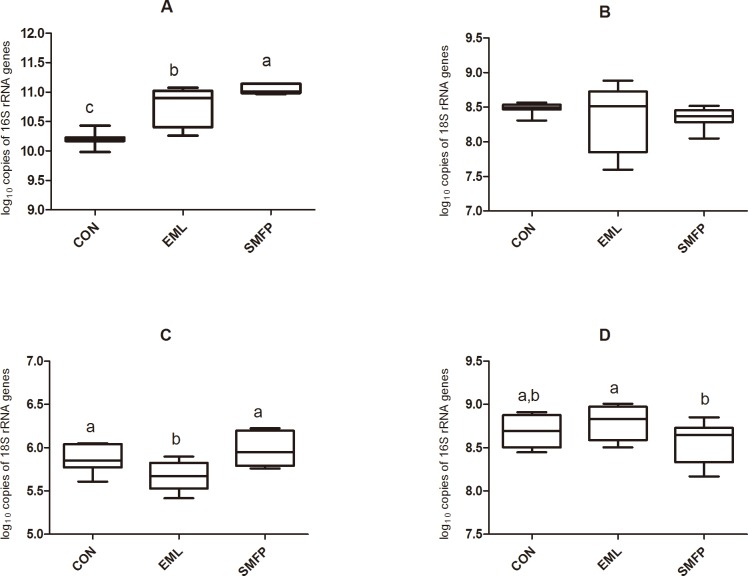
Abundance of microflora in the rumen of finishing steers when corn grain- and cotton seed meal-based concentrate was partially replaced with EML or SMFP.(A), abundance of total bacteria in the rumen; (B), abundance of fungi in the rumen; (C), abundance of protozoa in the rumen; (D), abundance of archaea in the rumen. The boxes represent the interquartile range (IQR) between the first and third quartiles (25th and 75th percentiles, respectively). The horizontal line inside the box represents the median. Whiskers represent the lowest and highest values within 1.5 times the IQR from the first and third quartiles, respectively. Different letters represent significant differences (p < 0.05). CON: control group (n = 4); EML: ensiled mulberry leaves group (n = 4); SMFP: sun-dried mulberry fruit pomace group (n = 4).